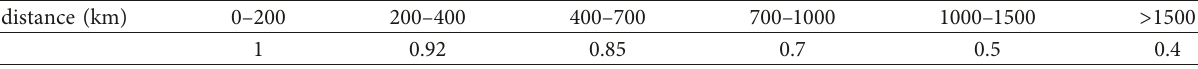
Table 3: Variation table of route extension coefficient (unit: km).